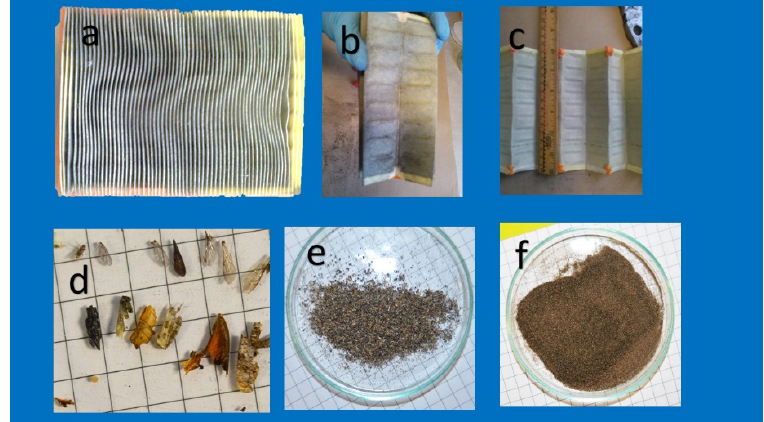
Figure 2. ( a) Car air filter collected, ( b,c ) blends show the dust trapped, ( d–f ) macroparticles and dust